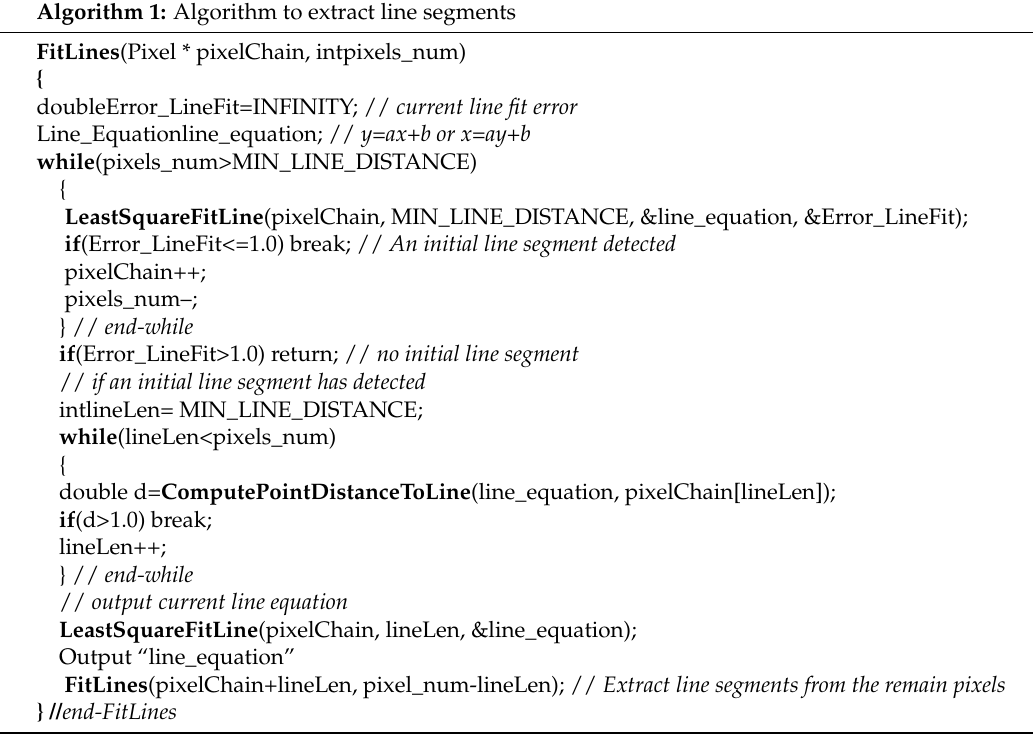
Table 1. Line segment extraction algorithm. Algorithm 1: Algorithm to extract line